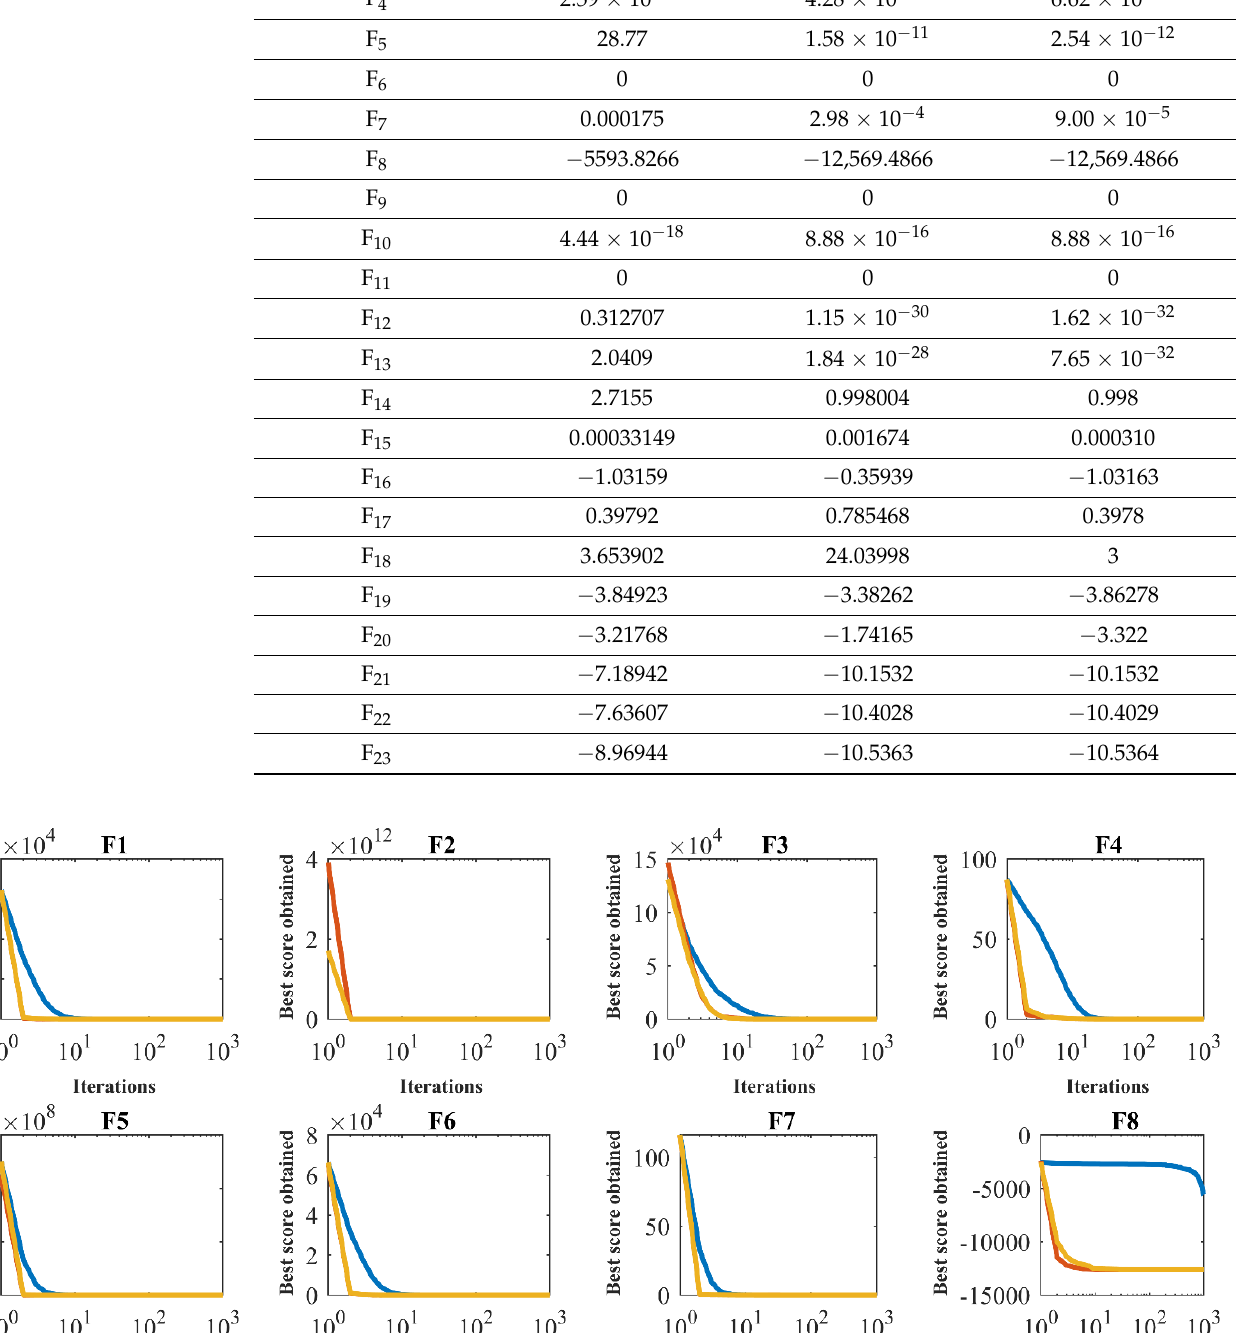
Table 8. Results of sensitivity analysis of SSVUBA to the effectiveness of each case in Equation (4).